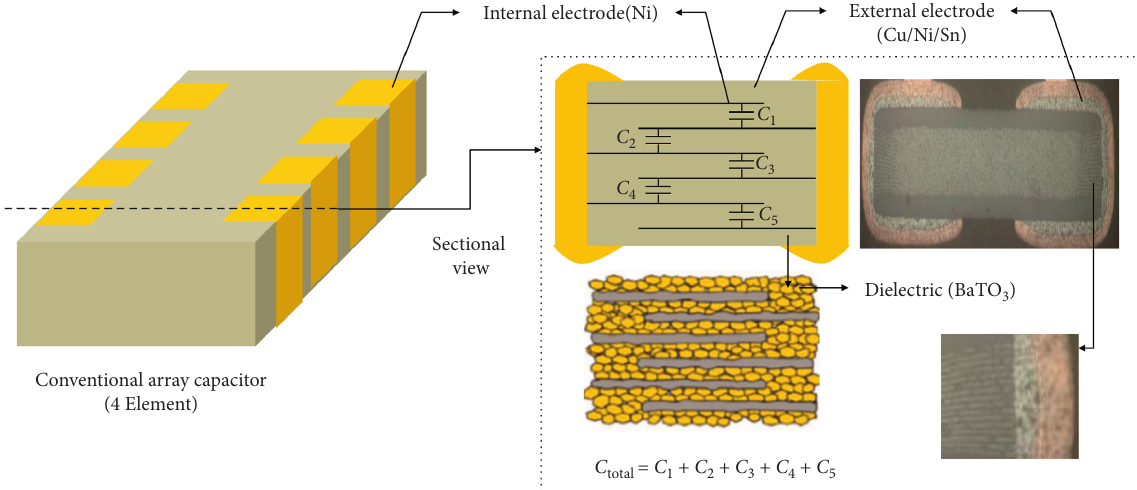
Figure 1: The structure of the conventional array